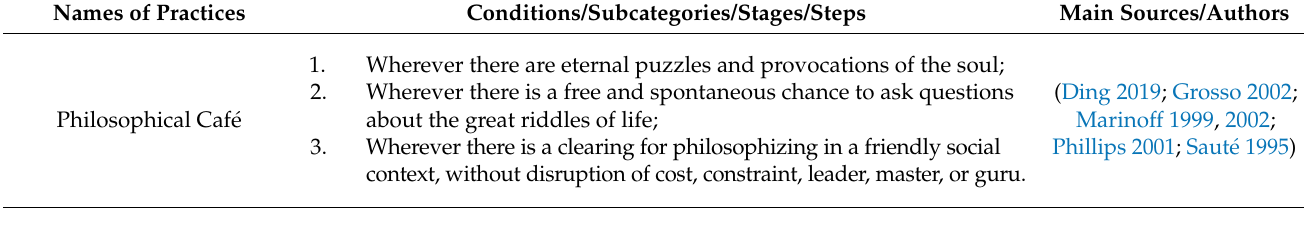
Table 2. Different practices of spiritual exercises in philosophical